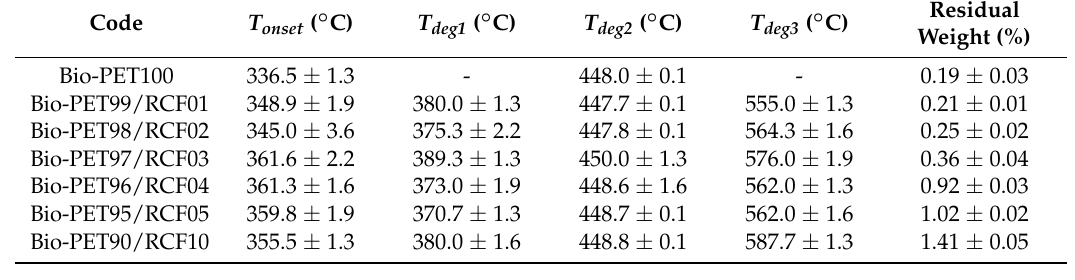
Table 4. Summary of the main thermal properties of the bio-based polyethylene terephthalate (bio-PET)/recycled cotton fiber (RCF) composite pieces in terms of the: onset temperature of degradation (T onset ), degradation temperature (T deg ), and residual mass at 700 °C. Code Bio-PET100